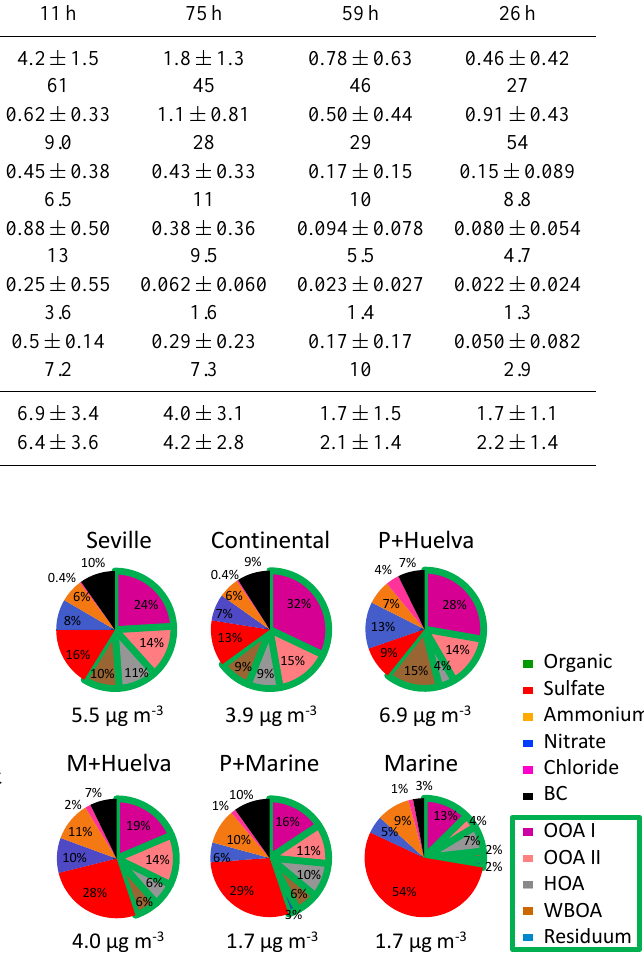
1 for each air mass type consisting of organics